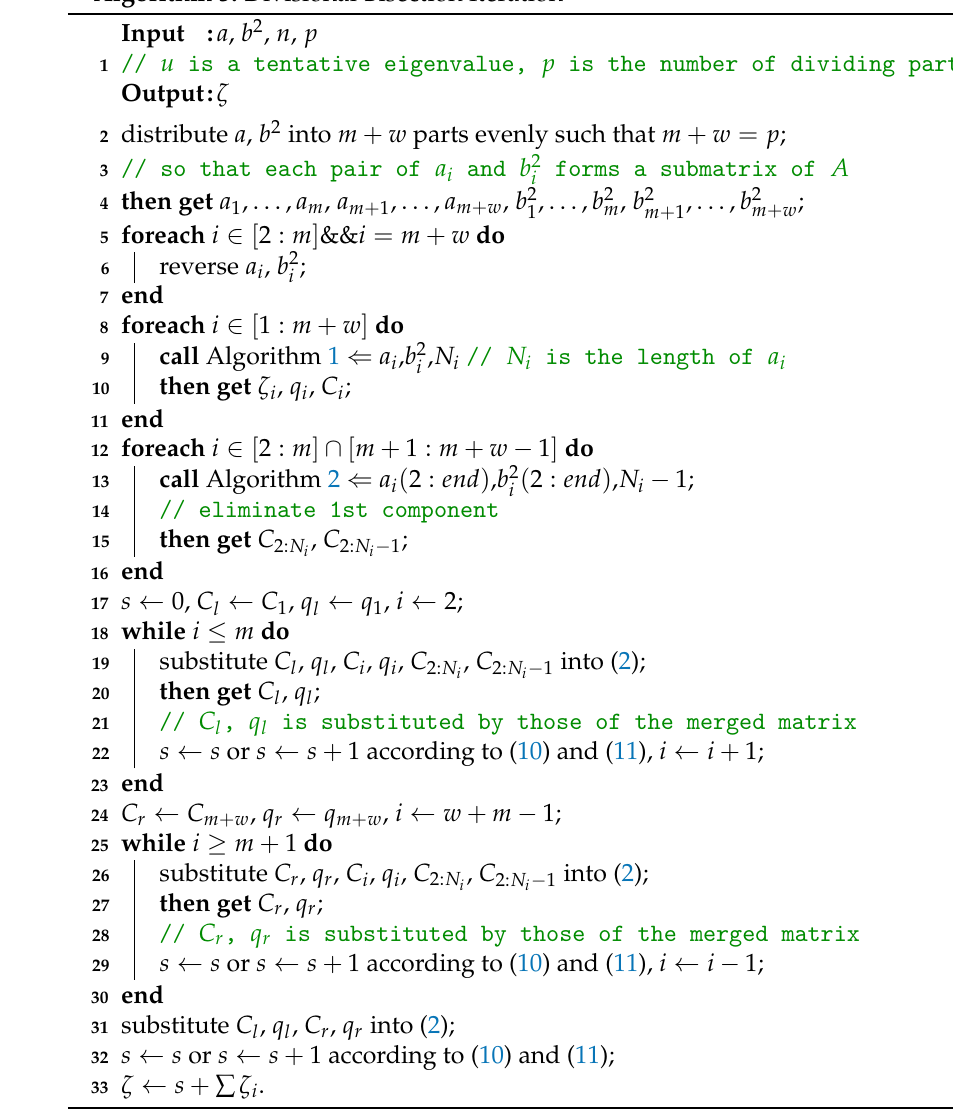
Algorithm 3 calls Algorithm 2 to compute p − 2 extra determinants of the